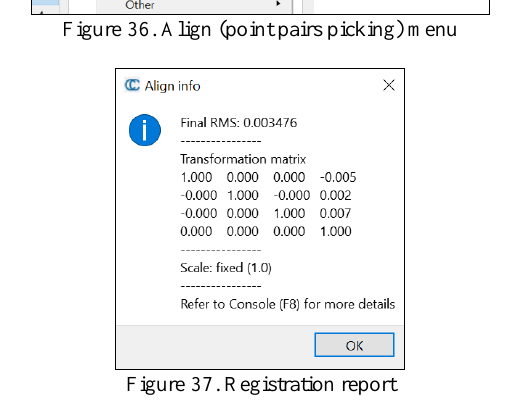
Figure 37. Registration report